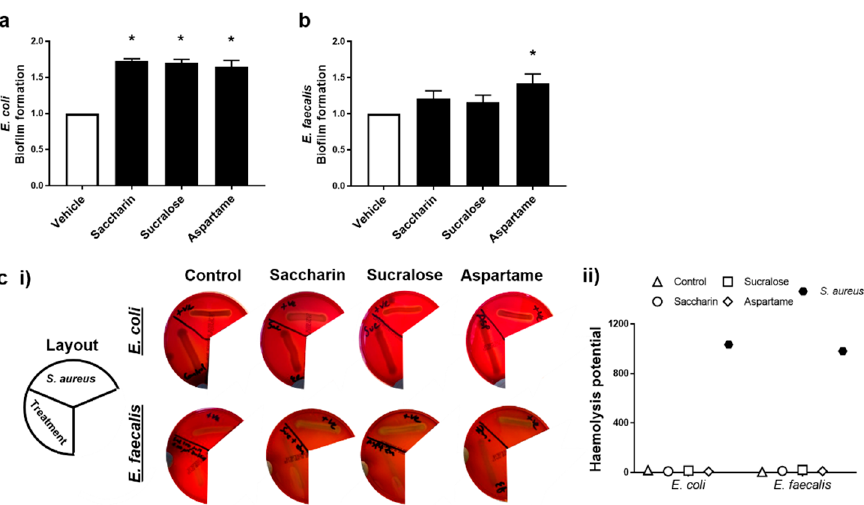
Figure 2. Artificial sweeteners differentially increase biofilm formation, but not haemolytic activ- ity, in the two model gut bacteria. E . coli (panel a ) and E. faecalis (panel b ) were exposed to artificial sweeteners, saccharin, sucralose, and aspartame (100 µM) for 24 h (panels a , b ) or 48 h (panel c ) and biofilm formation or haemolysis assay, respectively, were performed. For the haemolysis assay, S. aureus was used as a positive control to show haemolysin release (panel c ) using representative images (panel c ( i )) and semi-quantification (panel c ( ii )) of haemolysis. Specific bacteria for each study are included in underlined text. Data are presented as mean ± S.E.M for panel a and b and as mean only for panel c. * p < 0.05 versus vehicle for biofilm formation.